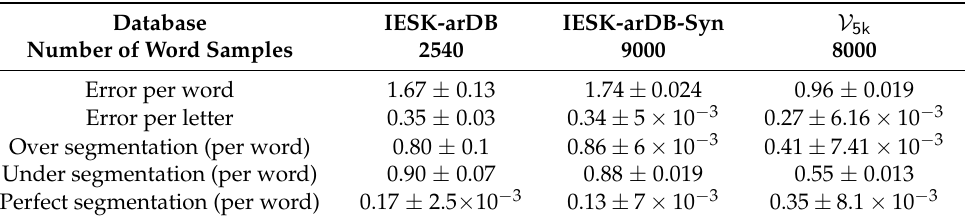
Table 2. Validation of the Segmentation